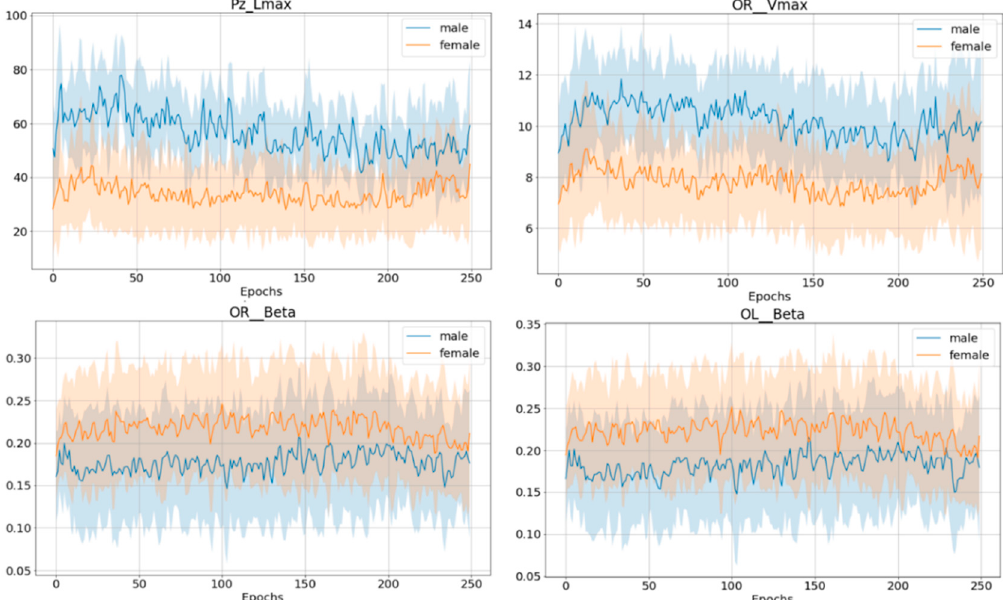
Figure 2. The difference between the average features of all male and all female drowsy drivers: Vmax from the OR region, Lmax from the Pz channel, relative beta power from the OR region, and relative beta power from the OL region. The Y -axis shows the values of observed features. The bold line is the mean of the feature, and the filled area represents the standard deviation.